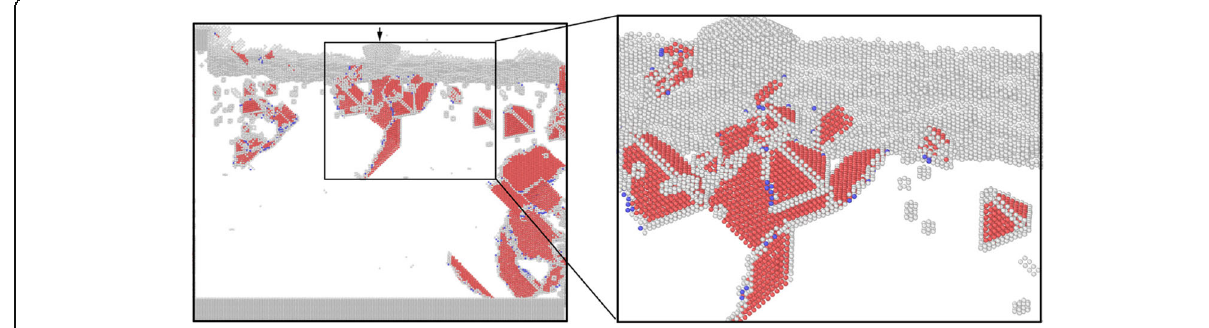
Fig. 6 Subsurface defects distribution of workpiece in initial indentation state (color online). The red, gray, and blue atoms are HCP, unknown, and BCC structure